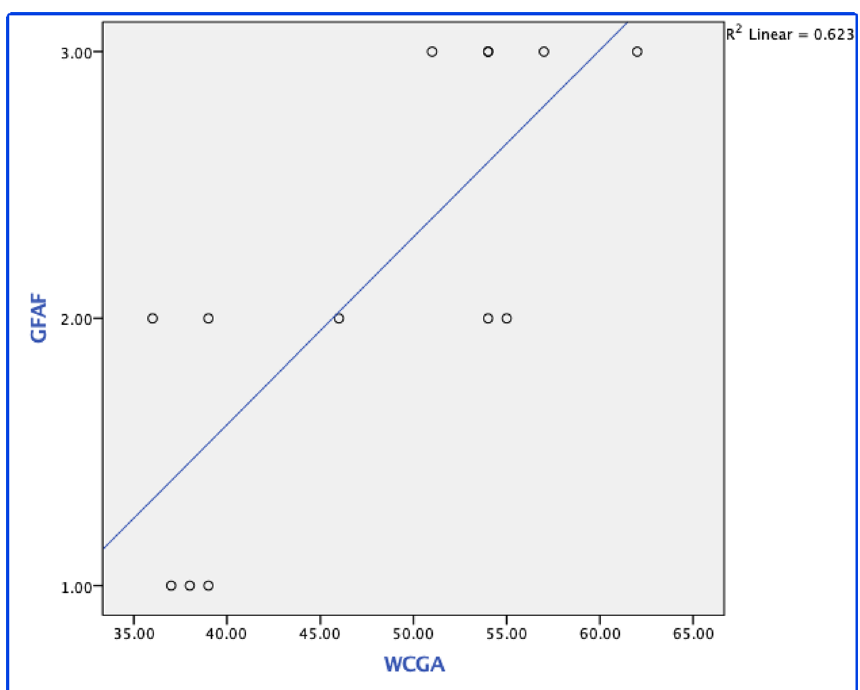
Figure 1. Scatter plot of fundus autofluorescence rank vs. weeks of corrected gestational age. Rank 1: On the optic nerve head (ONH) was visible; rank 2: only the ONH and peripapillary vessels/vascular arcade (PP/VA) were visible; and rank 3: the ONH + PP/VA and equatorial vessels (EqV) were visible. Spearman’s correlation: r = 0.714 ( P = 0.006).